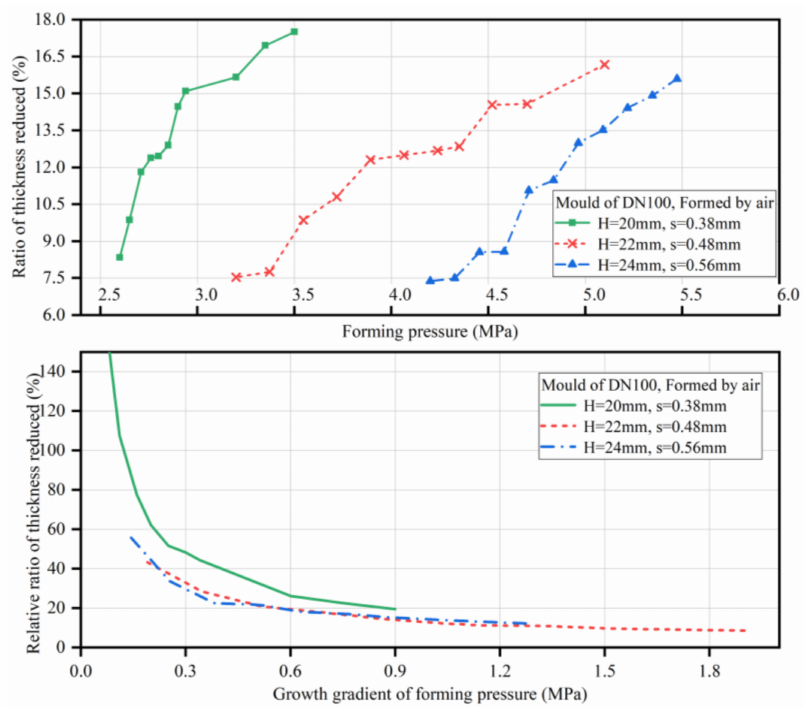
Figure 16. Absolute and relative ratios of thickness reduction for Dn 100 mm rupture discs formed by air.